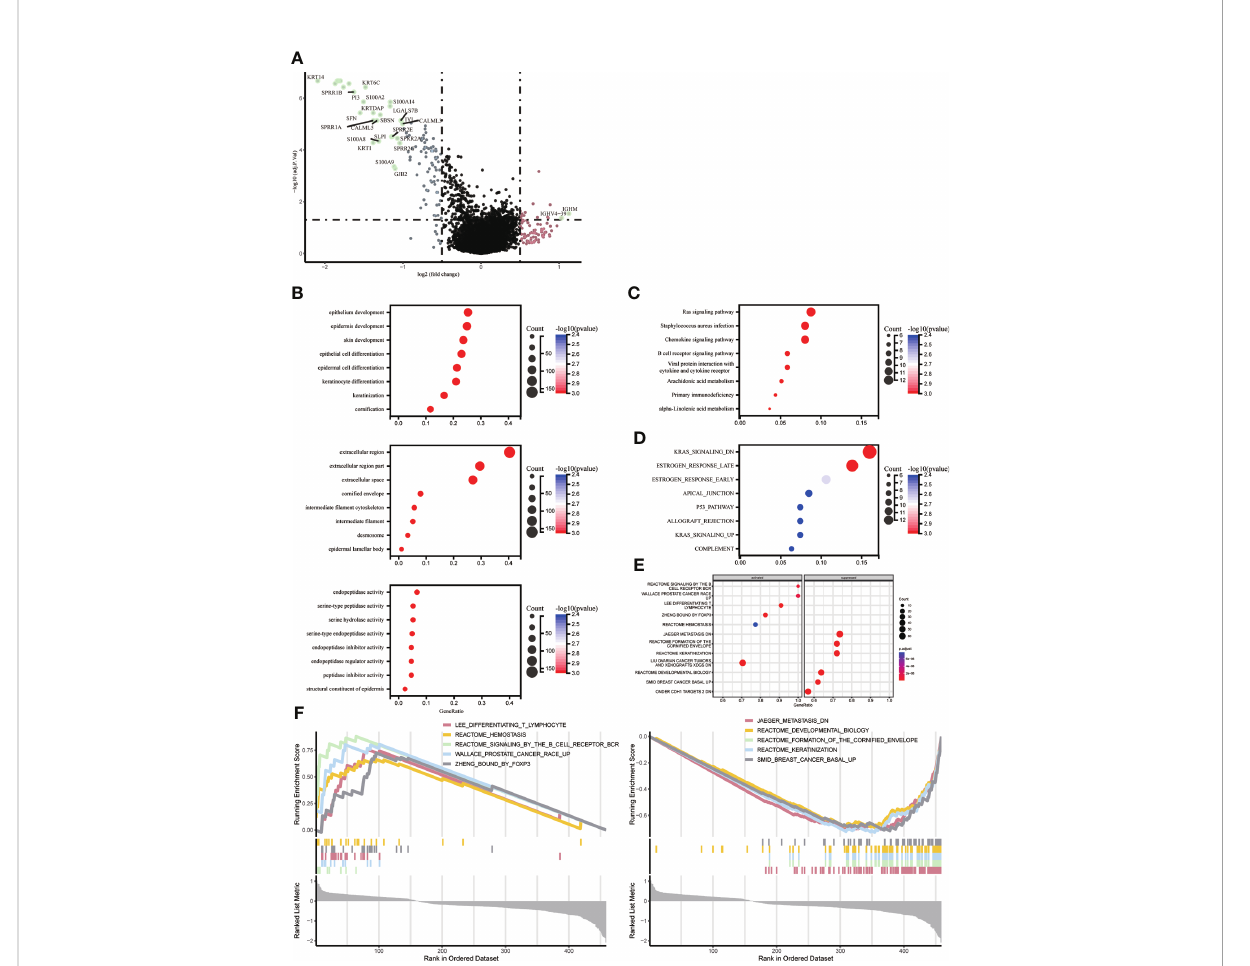
FIGURE 3 Identify differentially expressed genes (DEGs) and potential signaling pathways in different subtypes. (A) Volcano plot showing the quantitative distribution of DEGs between ICD-high and ICD-low subtypes in the TCGA cohortlog2-fold change in threshold > 1 and p < 0.05 (B – E) Bubble plots showing enrichment analysis of KEGG and GO signaling pathways. The size of the dots represents gene counts, and the color of the dots represents -log10(p adjust-value); (F) GSEA analysis identi fi es potential signaling pathways between ICD high and ICD low